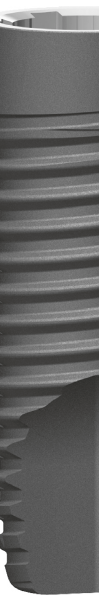
Figure 1: The design of the Neoss implant used in the